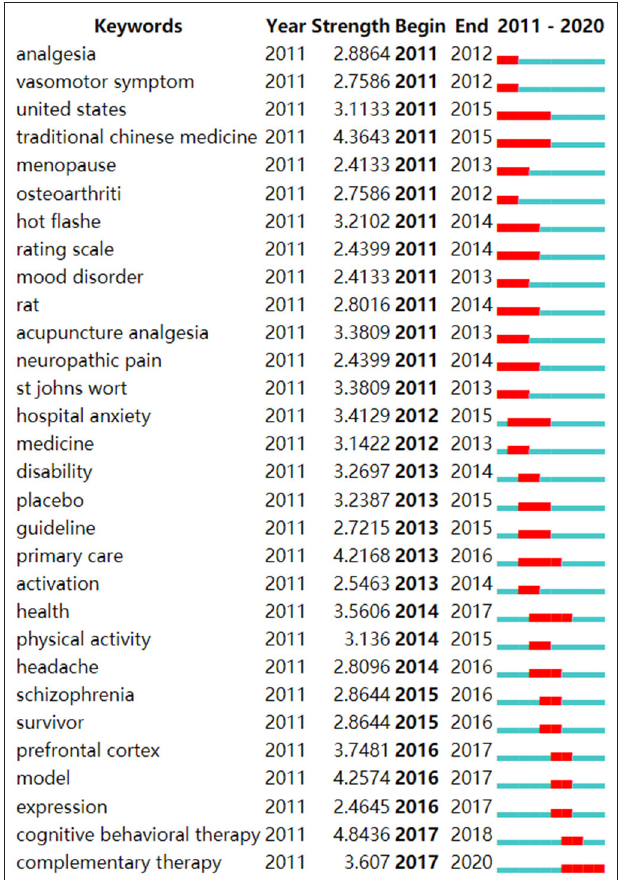
FIGURE 8 | Top 30 keywords with the strongest citation bursts. The red bar indicates that the keyword was frequently referenced, and the green bar indicates that the keyword was rarely